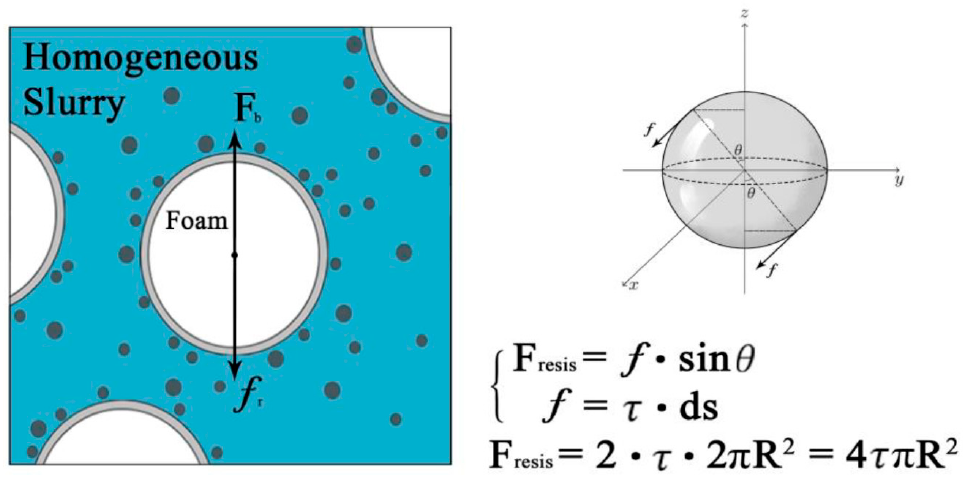
Figure 11. Force analysis of foam in